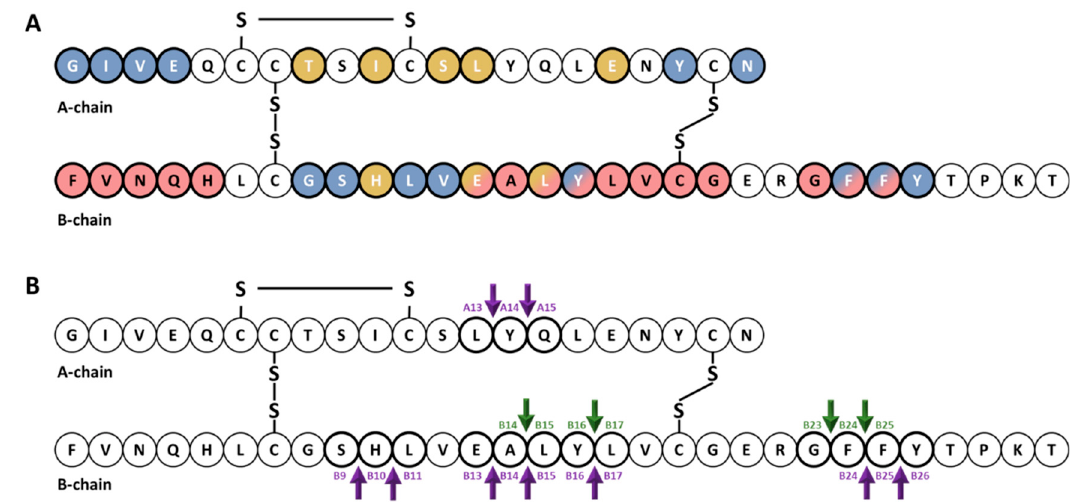
Figure 1. Cartoon illustrating the primary structure and cleavage products of human insulin. ( A ) primary structure of insulin showing amino acids that interact with IDE (red color) [63–65] and with site 1 (blue color) and site 2 (gold color) of the IR [66–69]. ( B ) cleavage products generated by endosomal proteases. At an early time, following insulin endocytosis, endosomal proteases account for major degradation products containing an intact A-chain, and cleavages in the B-chain (green arrows). Purple arrows indicate IDE cleavage sites effected by IDE in vitro [39].